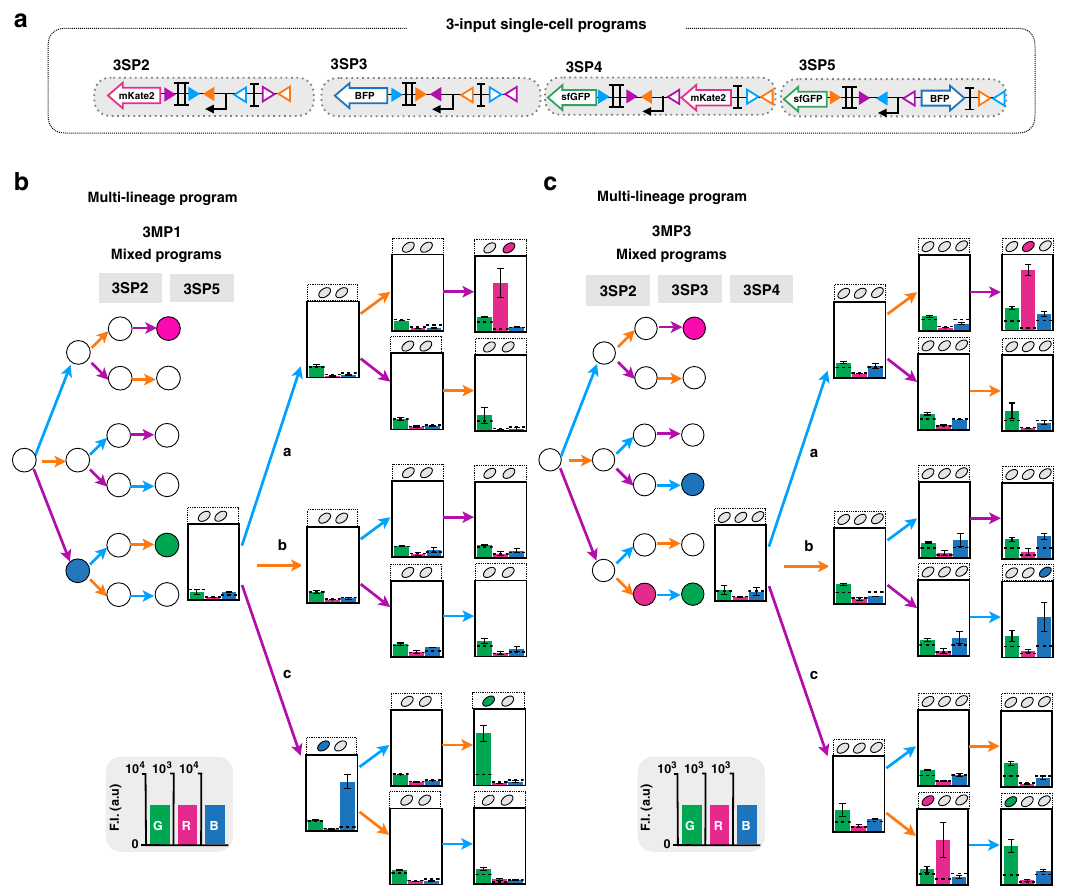
Fig. 6 Characterization of 3-input multicellular programs. Design and characterization of 3-input single-cell (single-lineage) programs operating in various lineages ( a ). Multicellular programs were composed by mixing two ( b ) or three ( c ) single-lineage programs. The inputs are represented by letters, a (blue) for aTc (expression of Bxb1 Integrase), b (orange) for arabinose (expression of integrase TP901-1), and c (purple) for benzoate (expression of Int5). Strains were mixed in equal proportions and sequentially induced three times for 16 h each, with different order of occurrences of inputs. The bar graph corresponds to the mean value of fl uorescence intensity (F.I.) in arbitrary units (a.u) for each fl uorescent channel (GFP, RFP, and BFP), with different and linear scales each. All experiments were performed in triplicate three times on three different days (data distribution in dot plots in Fig. S14). The error bars correspond to the ± standard deviation of the mean of the three different experiments performed in triplicate on three different days, and measured using a plate reader. The dotted line indicates the auto fl uorescence of negative control